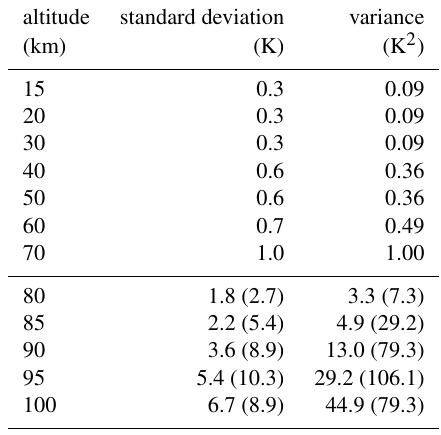
Table 2. SABER temperature precision (random error) for differ- ent altitudes. Values in the upper part of the table are for local ther- mal equilibrium (LTE) conditions and are taken from Table 2 at http://saber.gats-inc.com/temp_errors.php. Similar values are also found in Remsberg et al. (2008), their Table 1. For higher altitudes (lower part of the table) errors are increased because the retrieval has to account for non-LTE effects, involving additional uncertain- ties. Values in the lower part of the table are taken from Table 2 in Remsberg et al. (2008). Values in parentheses apply for cold sum- mer mesopause